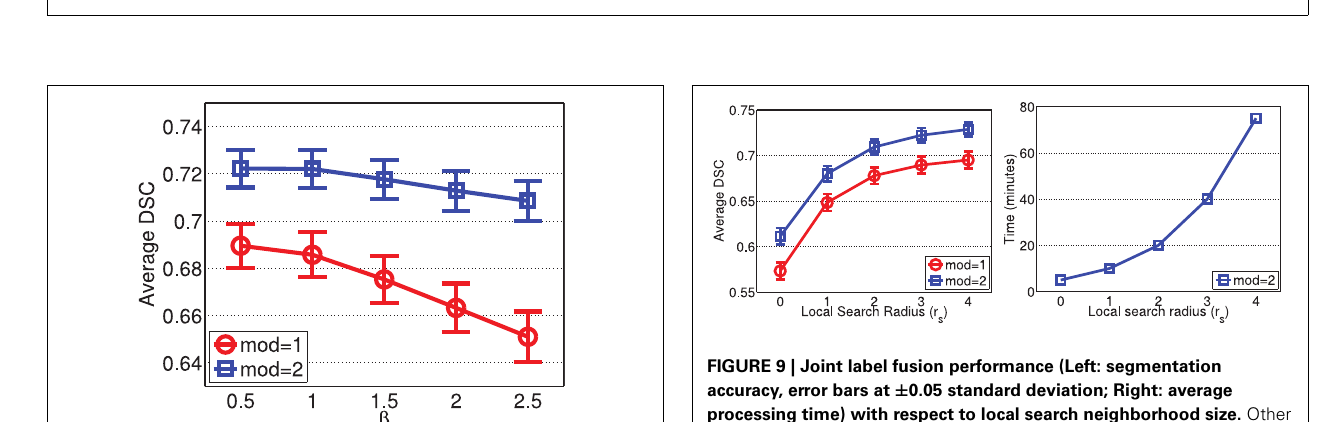
FIGURE 7 | Segmentations produced by manual segmentation, majority voting, joint label fusion with one imaging modality (JLF-Mod1), and joint label fusion with two imaging modalities (JLF-Mod2).